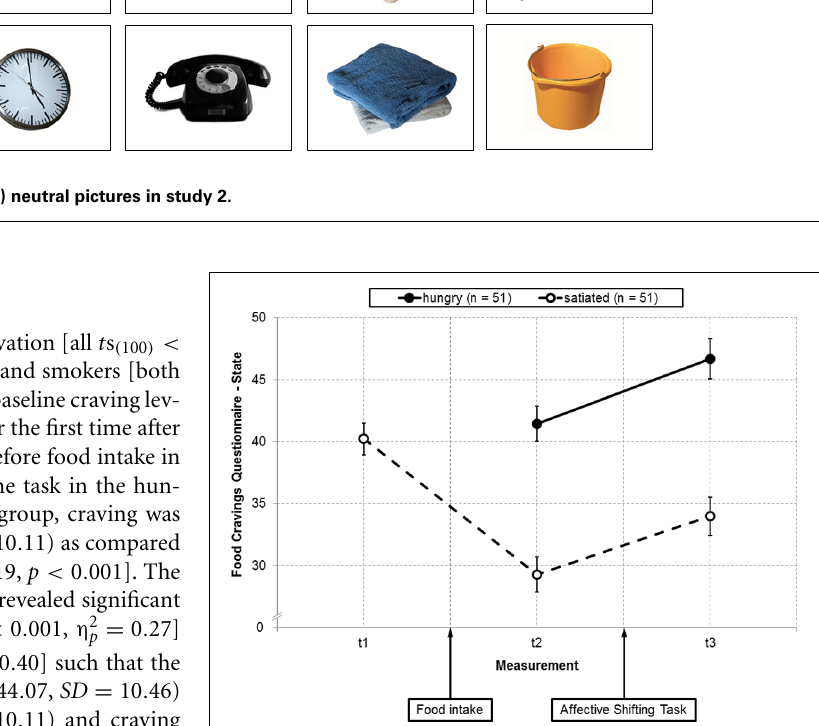
FIGURE 4 | Scores on the Food Cravings Questionnaire—State as a function of group before and after the Affective Shifting Task in study